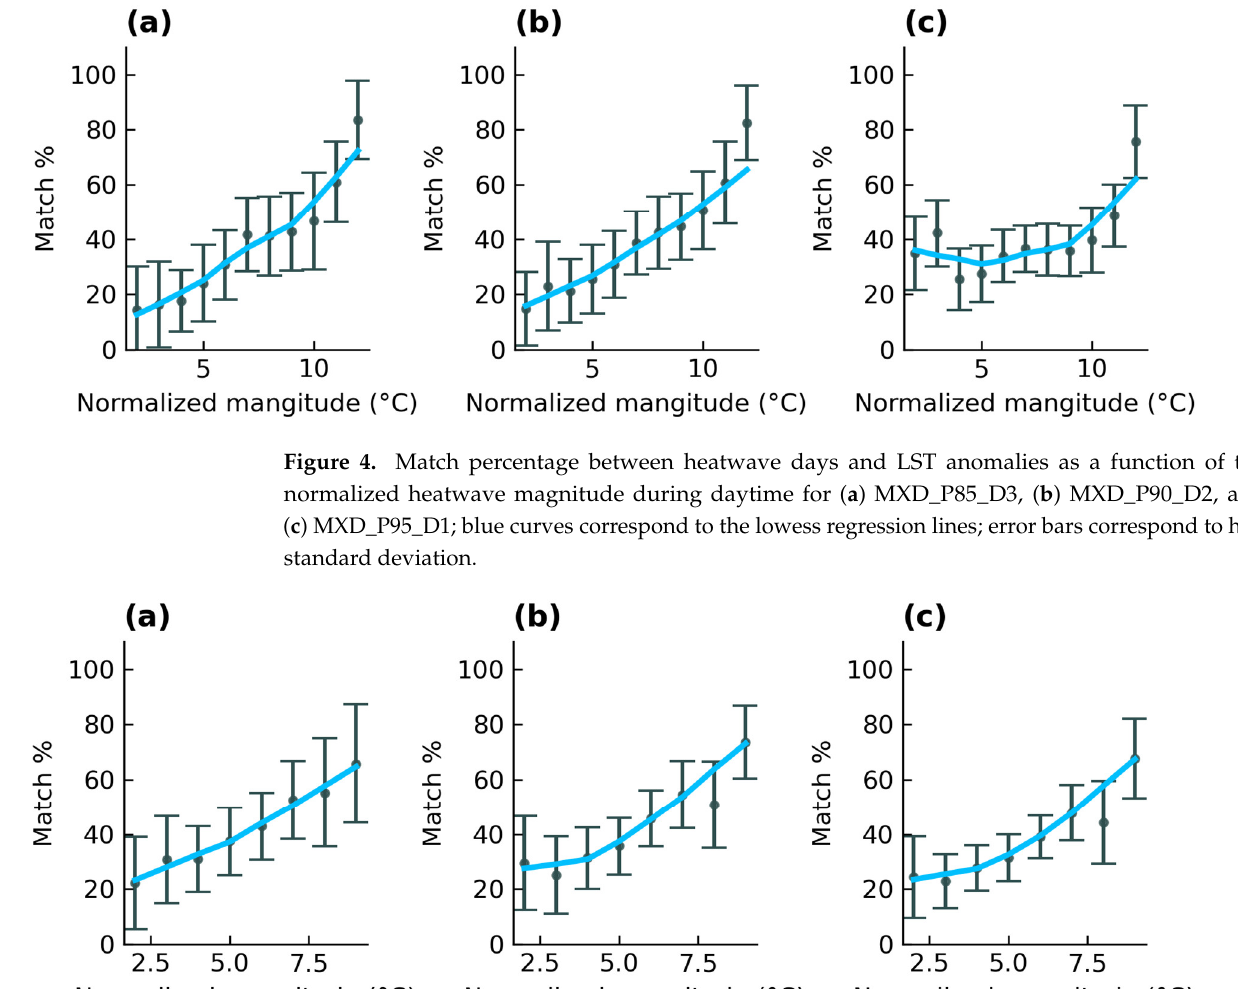
Figure 6. Match percentage between heatwave days and LST anomalies (MXD_P85_D3) per land cover type for ( a ) daytime and ( b ) nighttime. Only land cover types with at least 5% coverage are included.